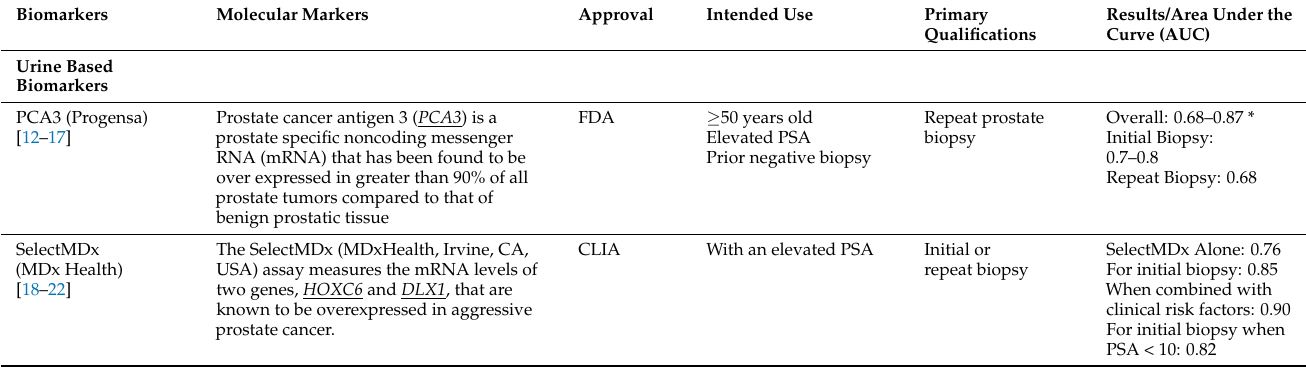
Table 1. Prostate cancer biomarkers in the decision- making tool/diagnosis of prostate cancer catego- rized by molecular markers, approving body, intended use, qualifications, and clinical